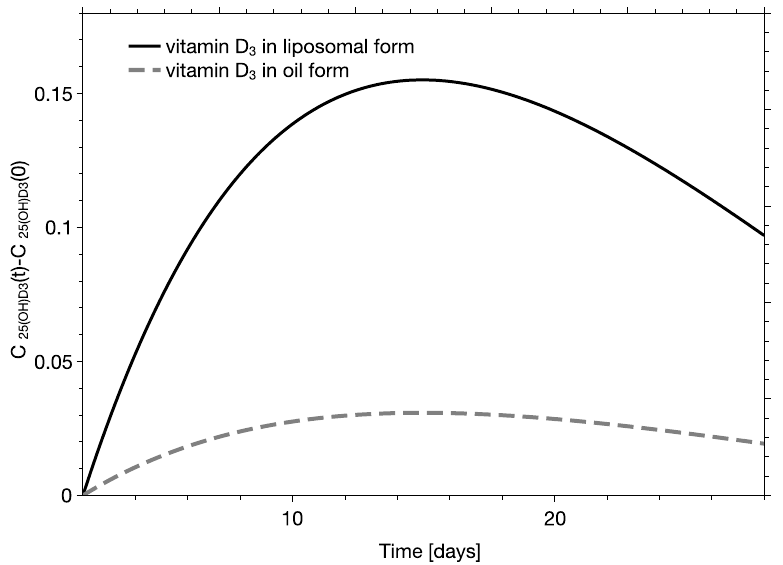
Figure 2. Example of the dependence of the increase of calcidiol concentration in serum ( 𝐶 25(𝑂𝐻)𝐷3 (𝑡) − 𝐶 25(𝑂𝐻)𝐷3 (0)) on time, as determined for a randomly selected person characterized by a low initial calcidiol concentration. The continuous and dotted curves represent the liposomal and oily formulation, respectively. The concentration of calcidiol in serum is in ng/L.